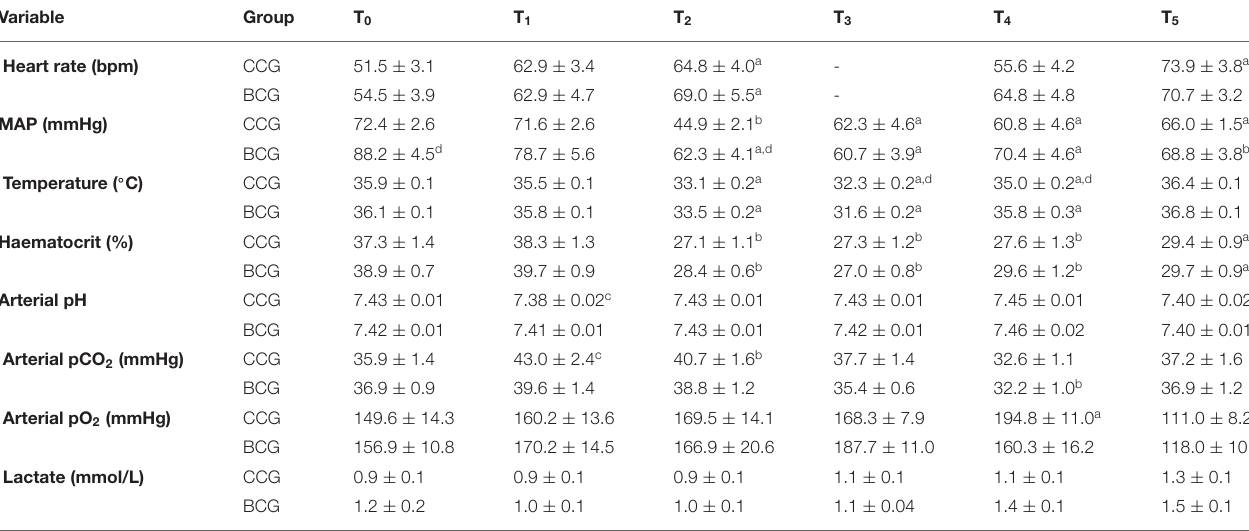
Values are presented as mean ± SEM. a p < 0.05 vs. T 0